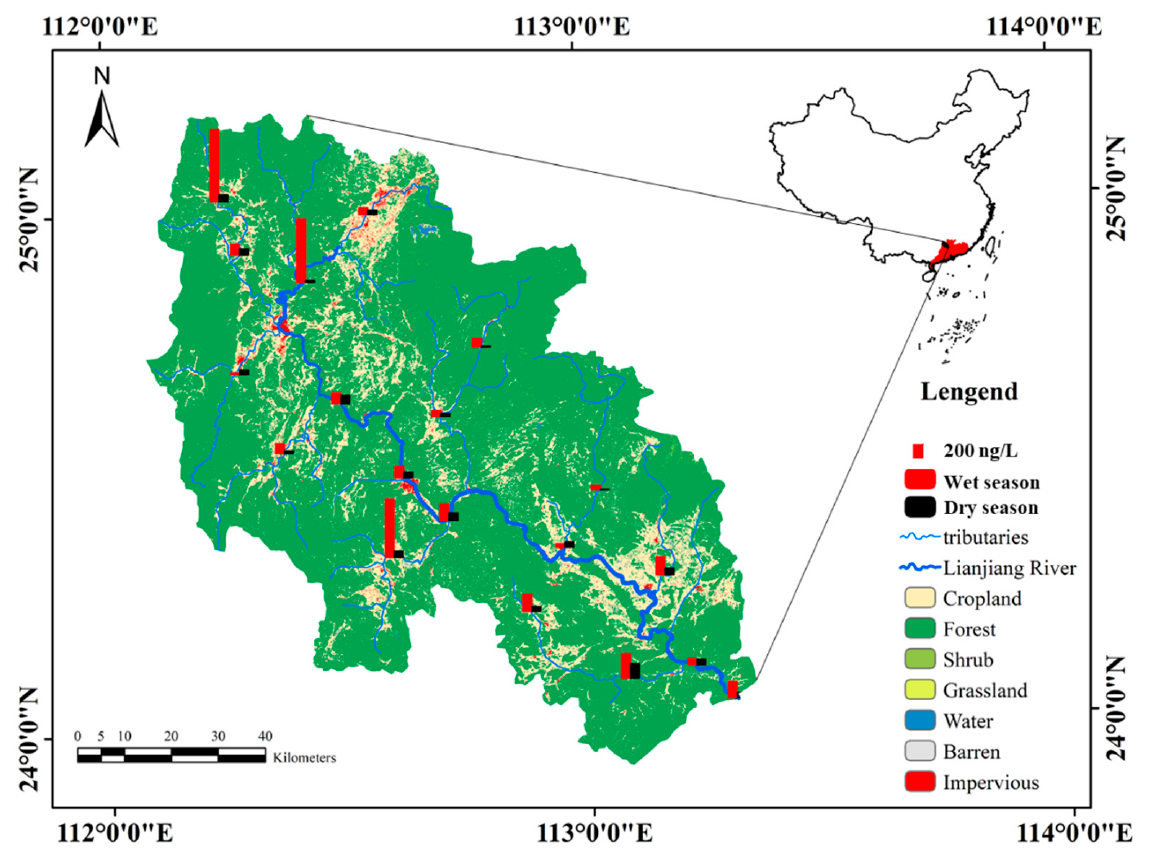
Figure 3. The accumulation concentration of PPCPs in the Lianjiang River in the wet and dry seasons, the red area is Guangdong province.